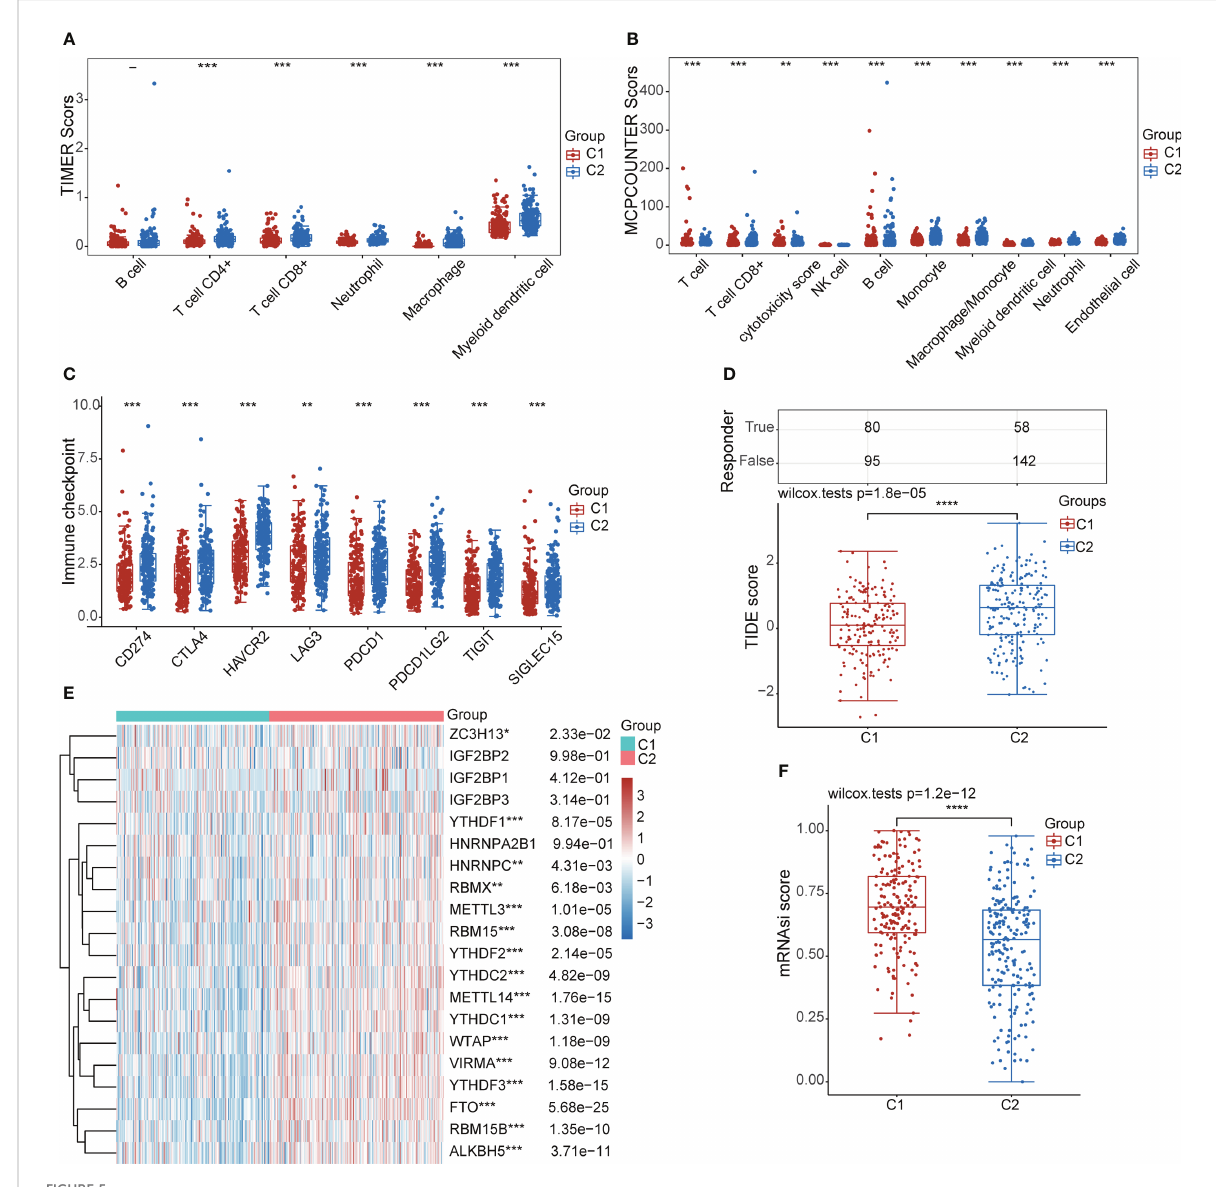
FIGURE 5 Characteristic analysis of different subgroups in the TCGA-STAD cohort. (A, B) Analysis of differences in the level of immune in fi ltration between the two subgroups. (C) Differential expression analysis of immune checkpoint-related genes between the two subgroups. (D) Analysis of the differences in TIDE scores between the two subgroups. (E) Heat map of differential expression of m6A methylation-related genes between the two subgroups. (F) Analysis of differences in tumor stemness scores between the two subgroups. (*: p ≤ 0.05, **: p ≤ 0.01, ***: p ≤